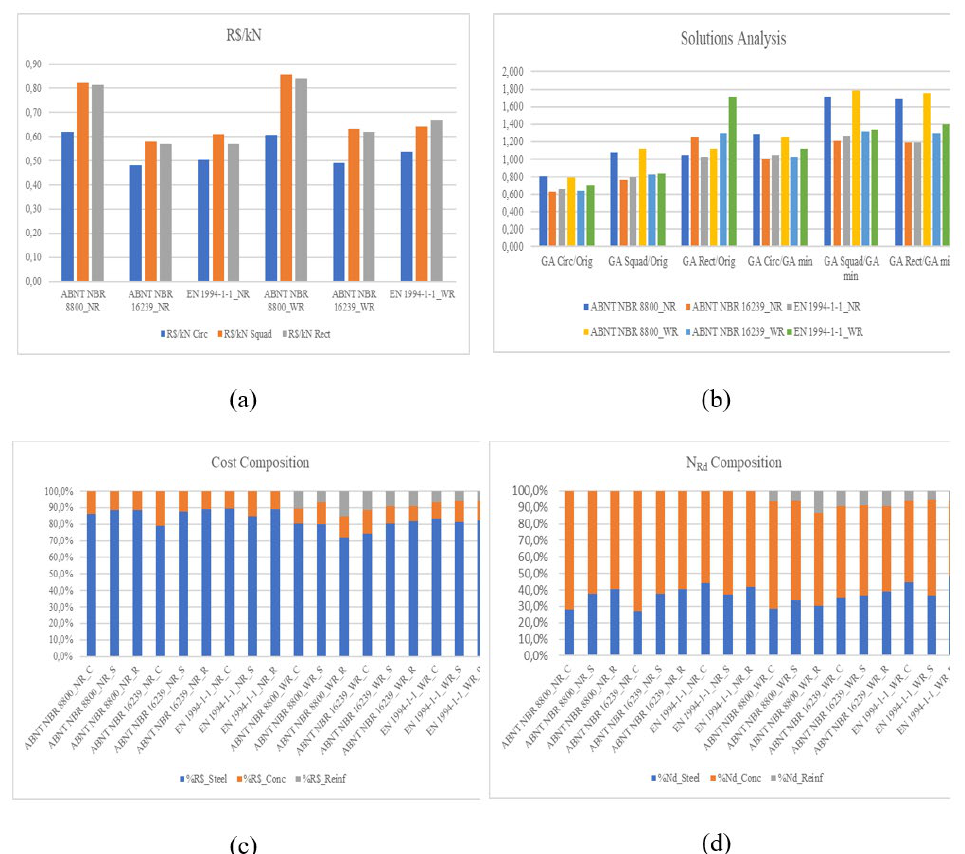
Figure 6 – (a) Ratio R$/N Sd ; (b) Ratio AG/Original Solution; (c) Cost composition of composite filled columns (d) Composition of the resistance to normal forces of the composite filled